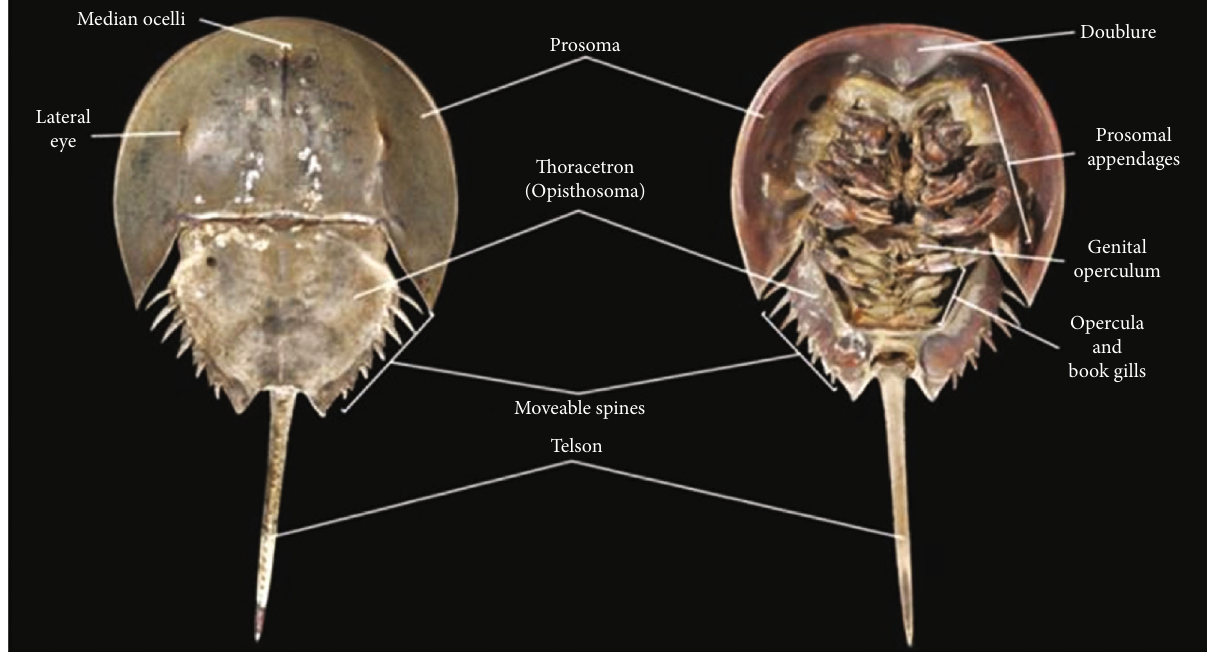
Figure 2: Basic morphological features of horseshoe crab [19].